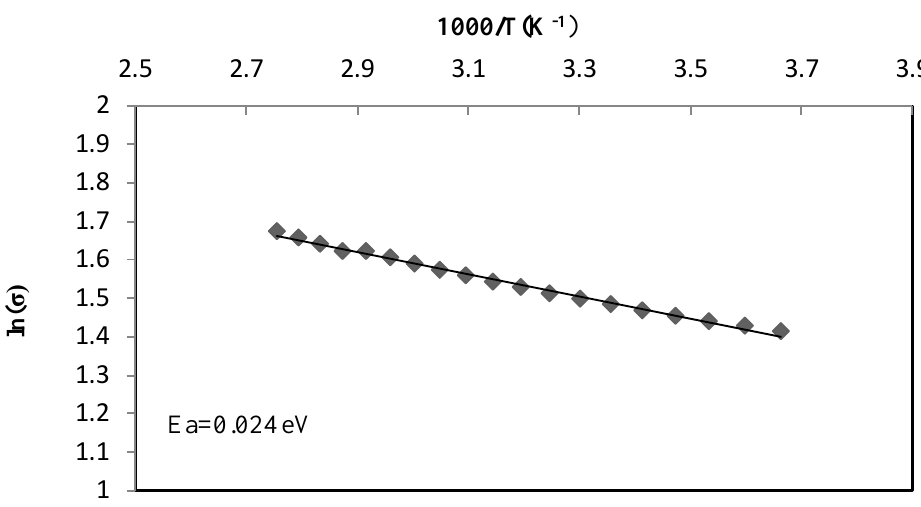
Figure 5 : Natural logarithm of conductivity against (1000 / T) for temperatures in the range 273-363 K.